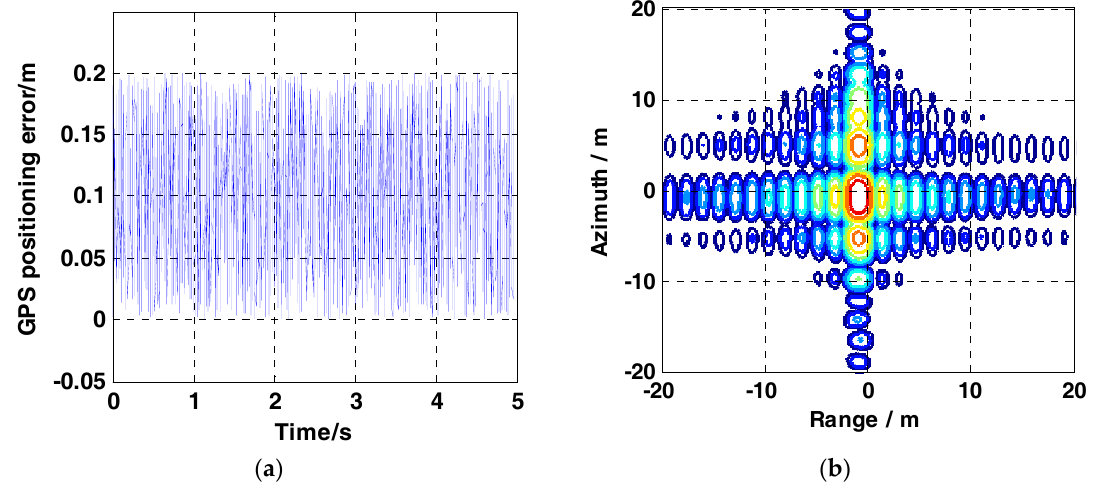
Figure 22. Simulation results with positioning error. ( a ) GPS positioning error. ( b ) Target 5’s contour